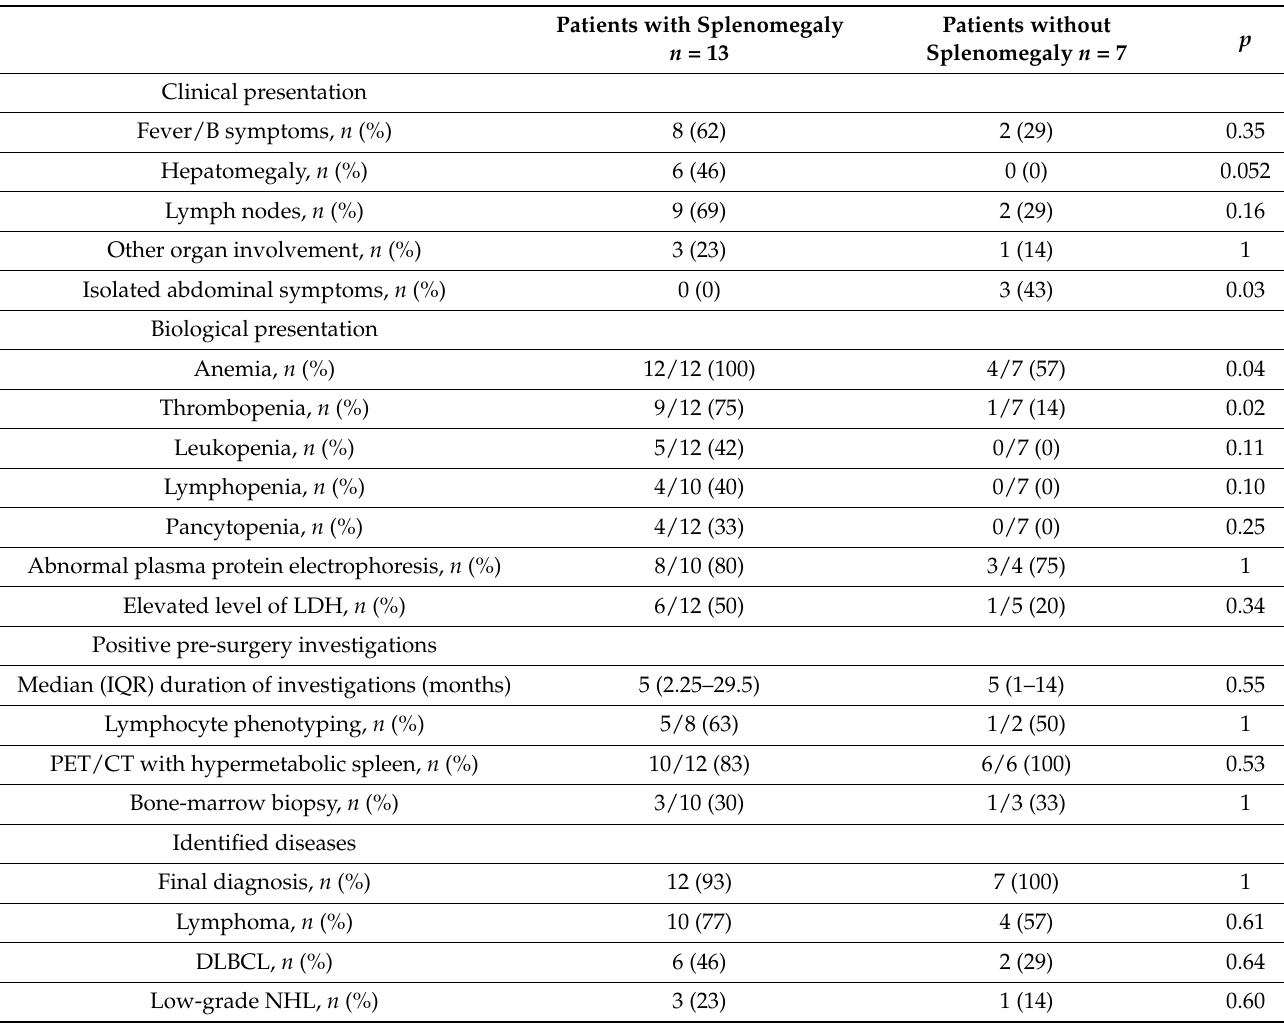
Table 3. Patient clinical and biological characteristics, investigations, and diagnoses according to clinical presentation *.